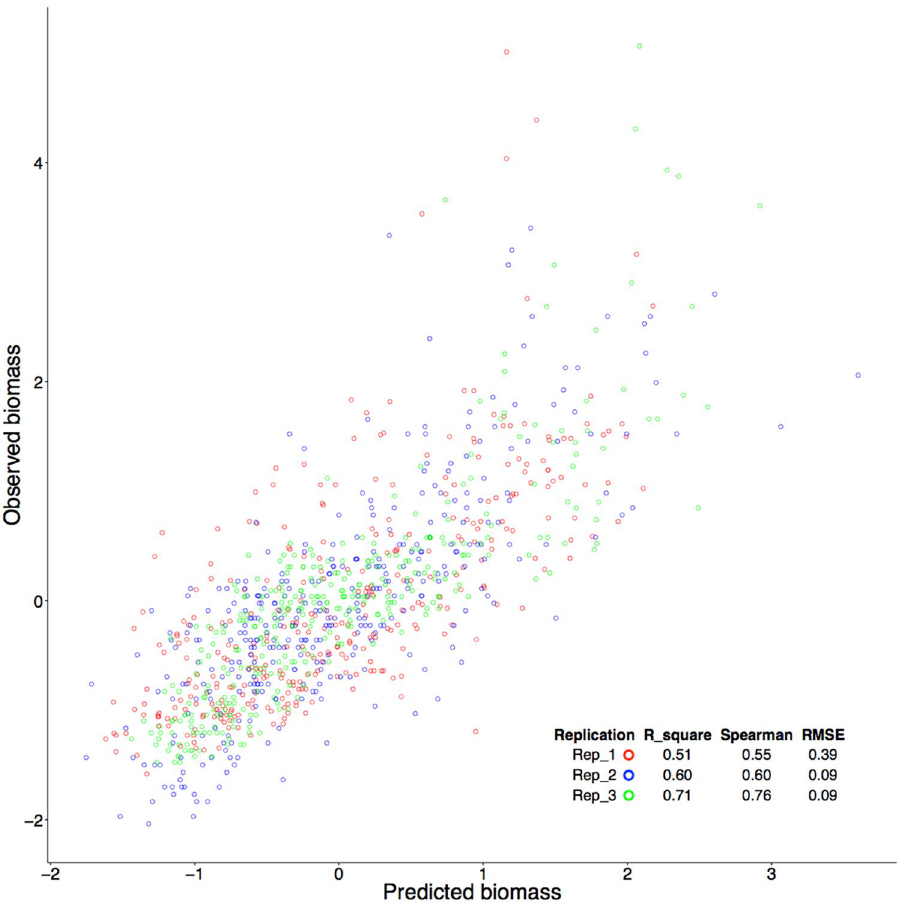
Figure 5. Validation of prediction accuracy in an independent field. The prediction model developed in the first field that was phenotyped and imaged in May, July, and September of 2019 was used to predict the biomass in the second field that was phenotyped and imaged in September of 2019. The three replicates in the second field are displayed with different colors. Prediction accuracy was calculated separately for each of the three replicates as the coefficient of determination (R 2 ), Spearman correlation coefficient, and Root mean square error (RMSE)